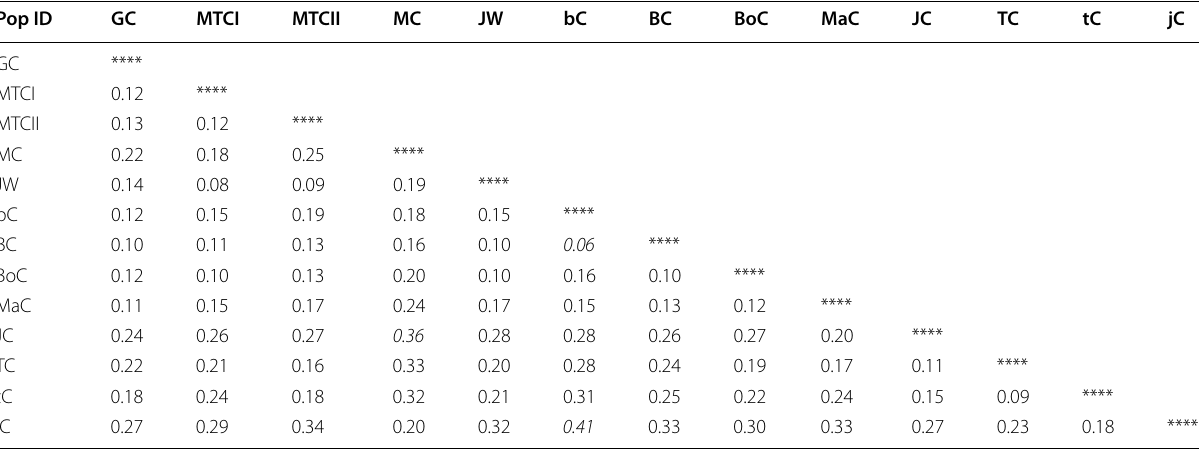
Italic values indicate the highest and lowest genetic distance between pairs of